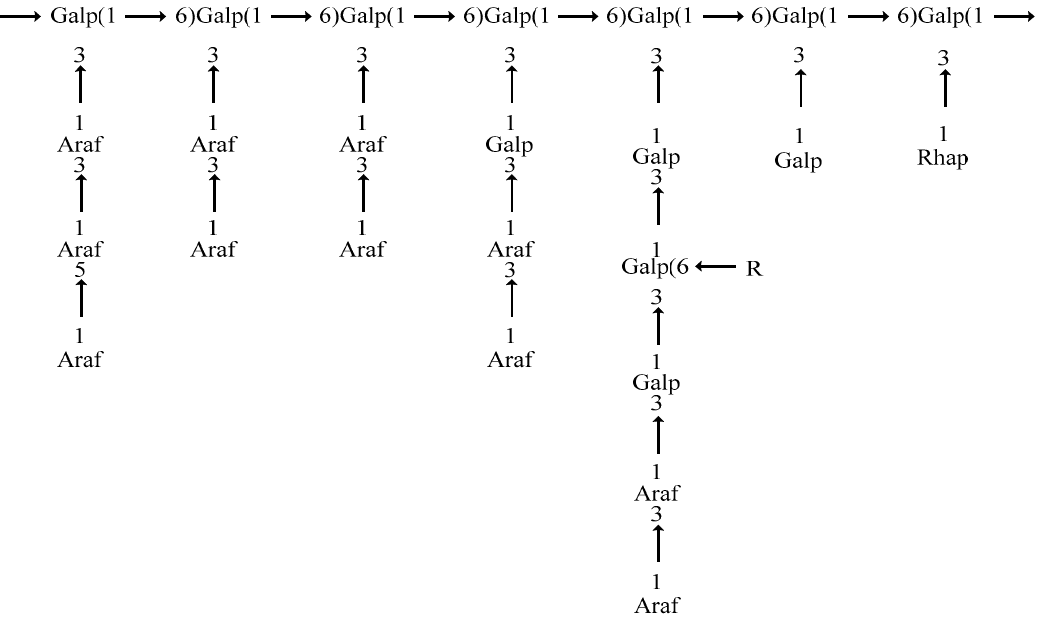
Figure 9. The presumptive structure of a homogeneous polysaccharide, LBP-W.